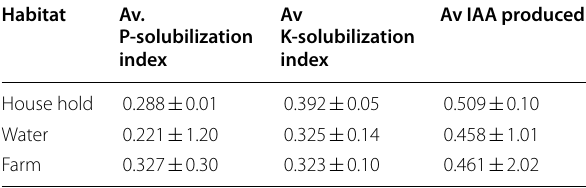
Mean values with different superscripts (alphabets) in a column are significantly different ( p < 0.05)